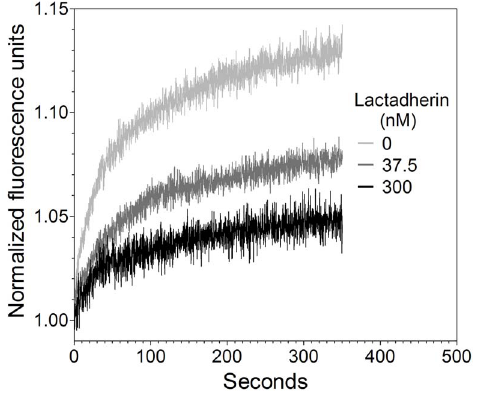
Figure 1. Cleavage of fluorescent phospholipid by nmPLA 2 and inhibition by lactadherin. Sonicated phospholipid vesicles, 10 m M, of composition PS:PE:PC:bbPC 4:20:75:1 were pre-incubated for 15 minutes in PBS, pH 7.2 at 22 u C with, or without, pure lipid-free bovine lactadherin before addition to a quartz cuvette of 3 6 3 6 45 mm. Vesicles were incubated for 5 minutes at 4 u C in the Peltier-thermostatted sample chamber of the fluorometer before adding nmPLA 2 to a final concentration of 0.06 U/ml. Reaction curves are normalized to baseline fluorescence intensity before addition of phospholipase as per Eq. 2.